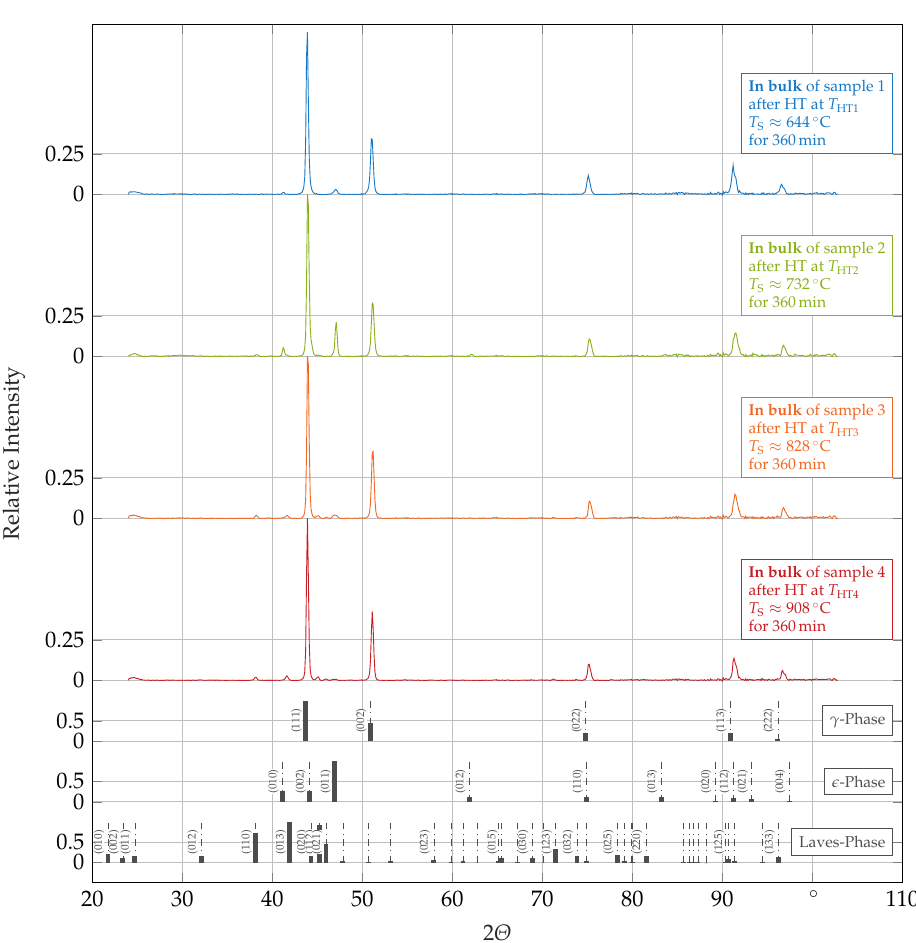
Figure 6. In color: Ex-situ XRD diffractograms, with intensities normalized to the highest peak in the respective pattern, of samples composed of a Co-Cr-W alloy in states AB by L-PBF and after HTs measured on the samples’ bulk. Additionally in grey: Stick reference pattern calculated with VESTA [32] of a solution of W in Co fcc γ -phase (COD:1524796 [33]), a solution of W in Co hcp (cid:101) -phase (COD:1524797 [33]), and a W 2 Co 3 Si Laves-phase